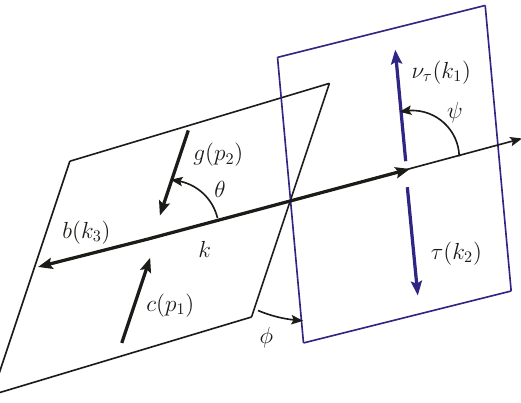
Figure 5 . The definition of three angles in our coordinate system for the process cg → τνb . We factorized 2 to 3 process effectively as the product of 2 to 2 process and 1 to 2 process. The artificially introduced intermediate momentum k corresponds to the momentum of the τν system (whether or not it is associated with a